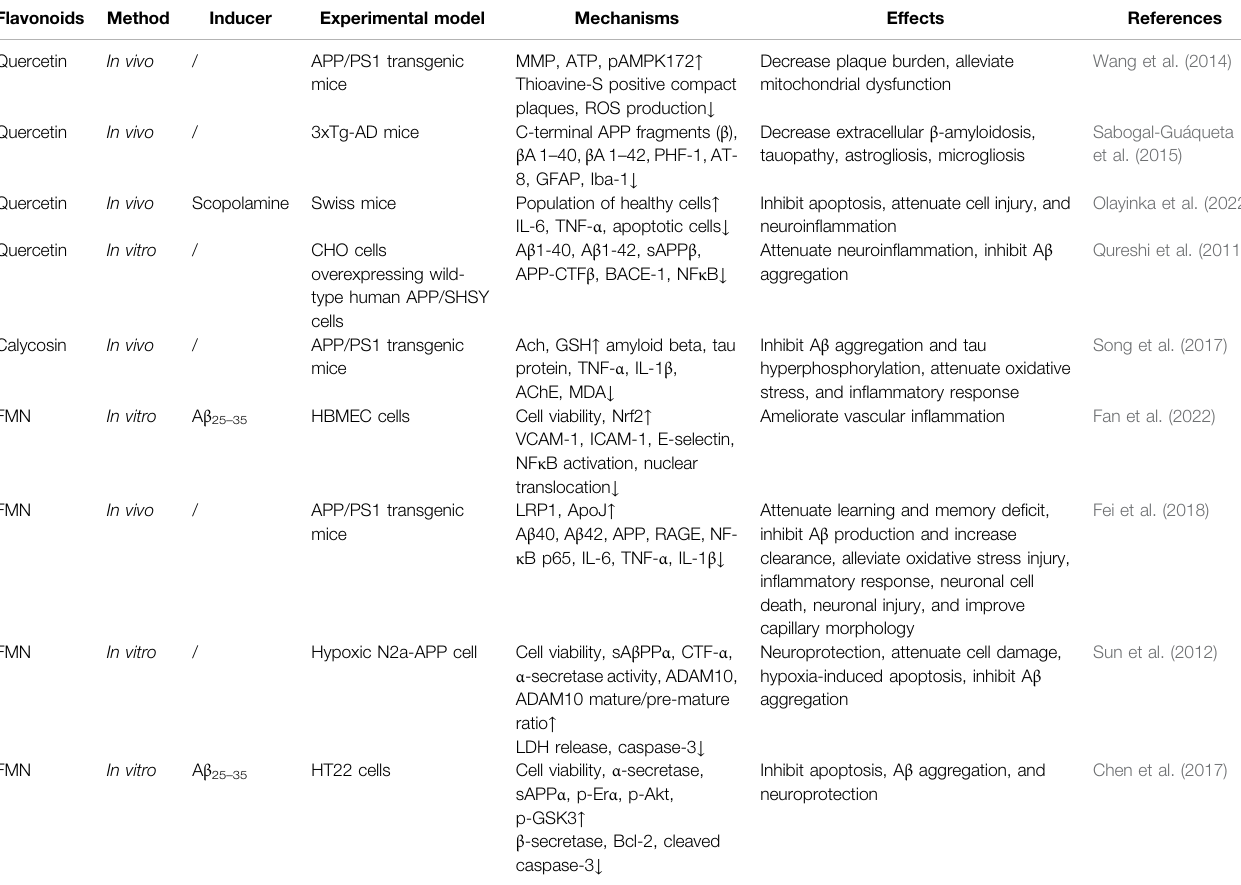
TABLE 2 | The effect and mechanisms of fl avonoids from Astragali radix against Alzheimer ’ s disease. Flavonoids